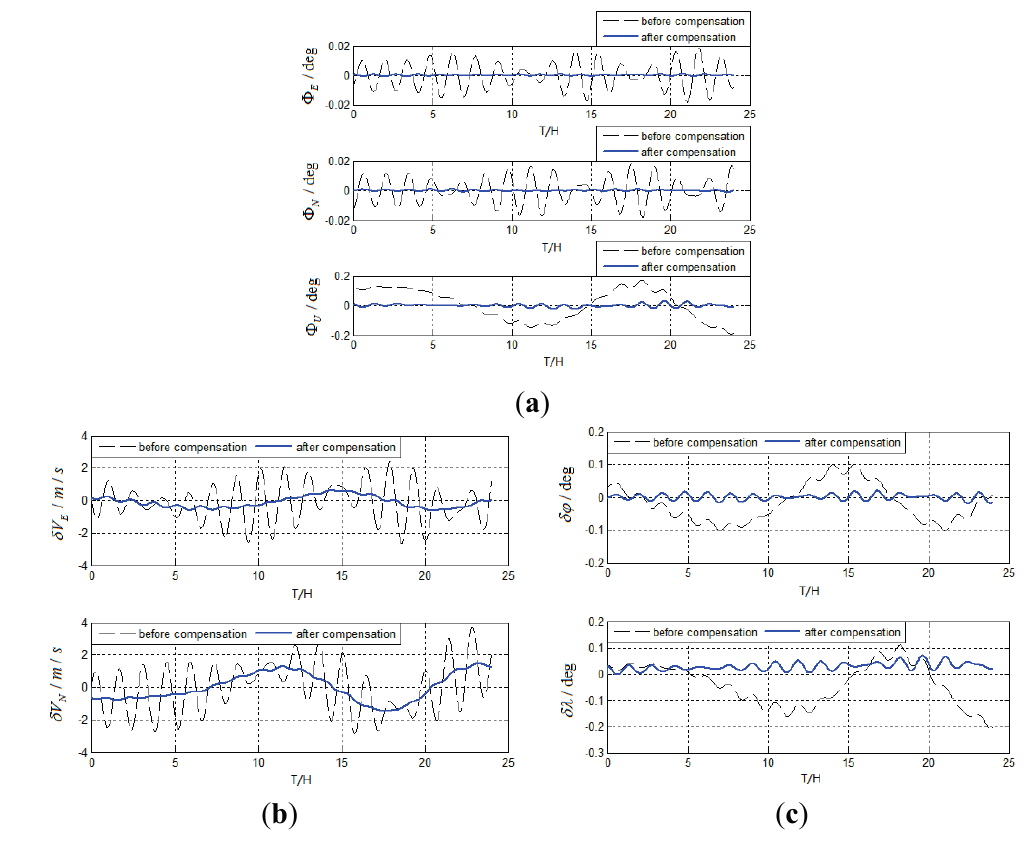
Figure 8. ( a ) Simulation results of attitude errors for maneuvering carrier with no inertia device errors; ( b ) Simulation results of velocity errors for maneuvering the carrier with no inertia device errors; ( c ) Simulation results of position errors for maneuvering the carrier with no inertia device